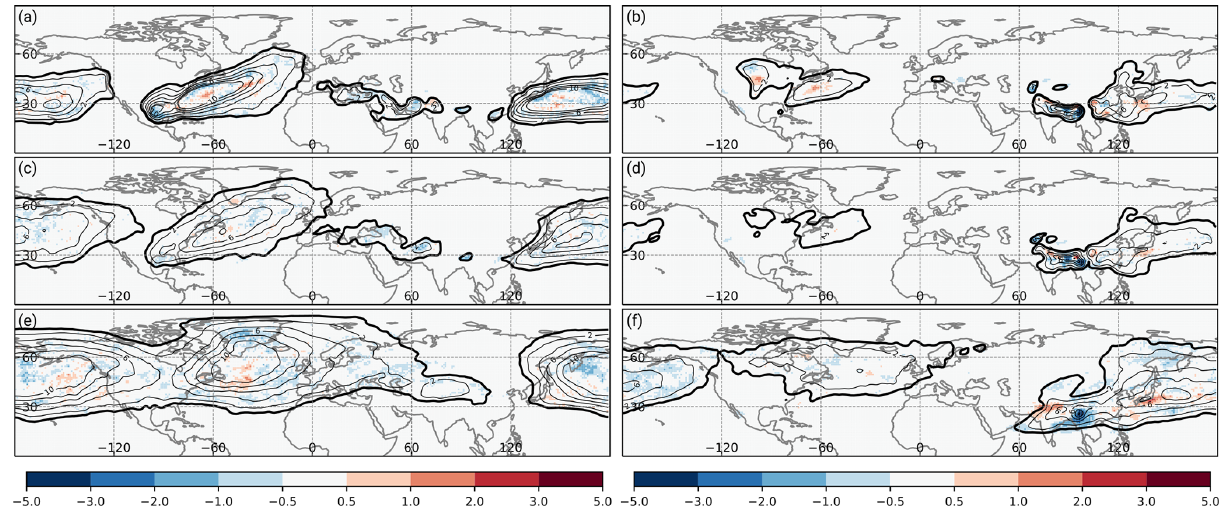
Figure 4. Climatological occurrence frequency bias for WCB (a, b) inflow, (c, d) ascent, and (e, f) outflow (shading is absolute frequency bias in percent) of the CNN models compared to the trajectory-based climatology (thick black contour at 1%; thin black contours every 2%). Panels (a, c, e) are for DJF in the period 1 December 2005 to 29 February 2016, and panels (b, d, f) are for JJA in the period 1 June 2005 to 31 August 2015.